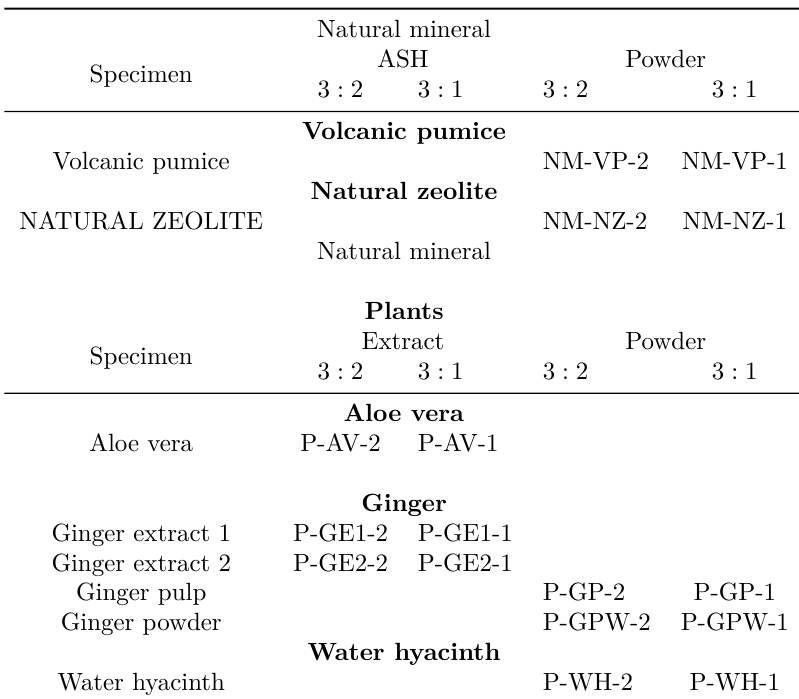
Table 3. Industrial waste as candidate materials in reducing DO level.